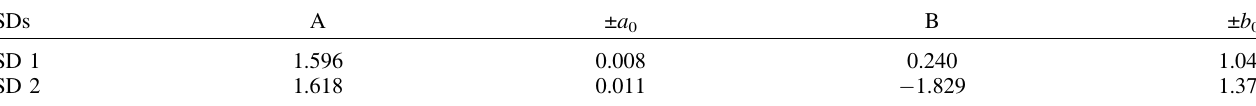
Table A.2. Linear regression coef fi cients for both